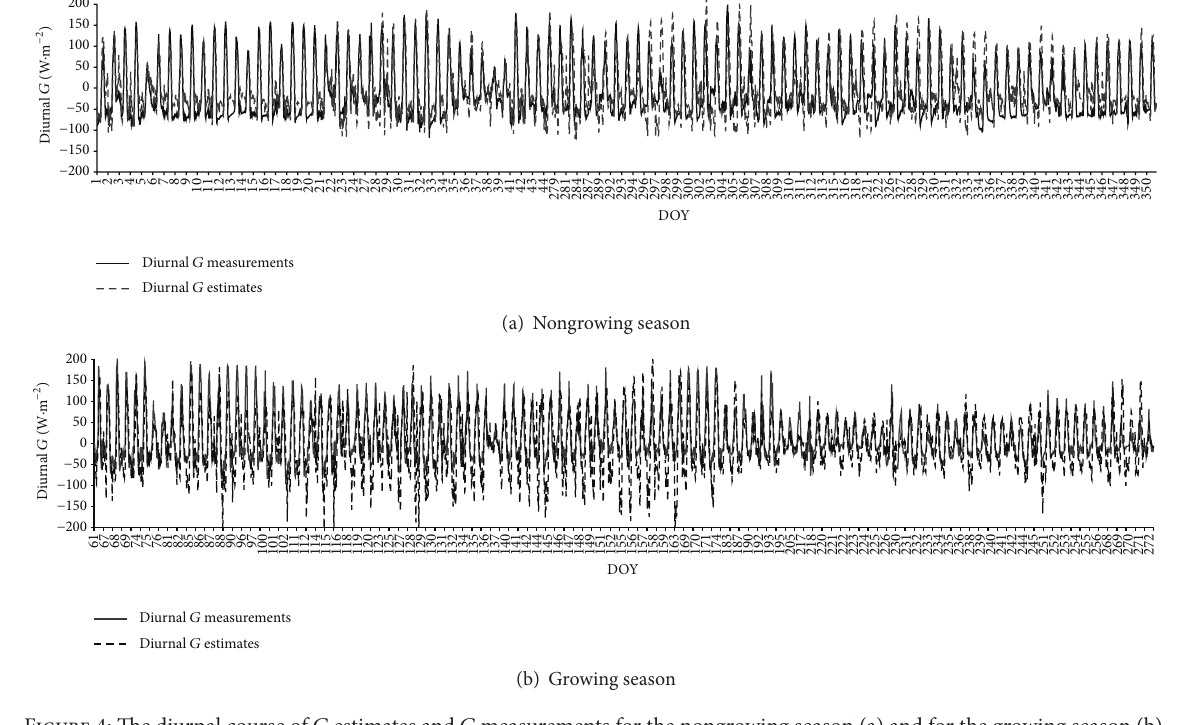
on the radiation measurements induces a lower estimate of the summation of harmonic terms at nighttime. The same phenomenon was found in the study of Murray and Verhoef [9]. They attributed this to the differences between canopy and soil